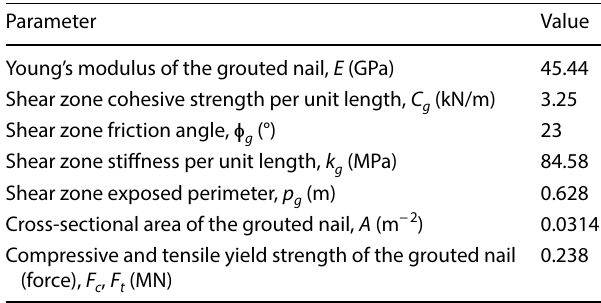
Table 3 Properties of the structural elements of the nail used in modeling Parameter